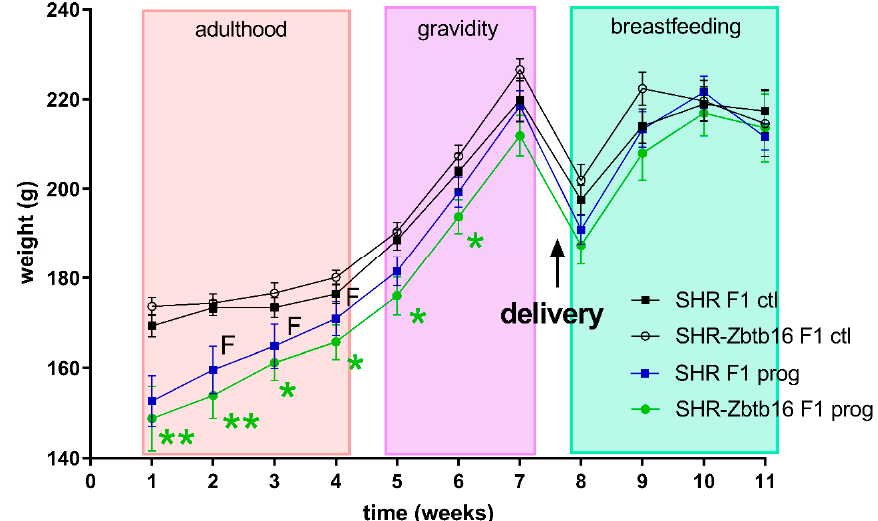
Figure 3. Body weight measurements of F1 SHR and SHR-Zbtb16 adult female rats during weeks prior to pregnancy (weeks 1–4), in pregnancy (weeks 5–7) and during lactation (weeks 8–11). Delivery occurred between weeks 7 and 8. SHR F1 controls—black boxes, F1-programmed SHR—blue boxes, SHR-Zbtb16 F1 controls—white circles, F1-programmed SHR-Zbtb16—green circles. Data are expressed as mean ± SEM. The strain comparison using the post-hoc Fisher’s least significant di ff erence test of the two-way ANOVA for STRAIN and PROGRAM as major factors are indicated as follows: * p < 0.05, ** p < 0.01. E ff ect of programming in SHR and SHR-Zbtb16 strains is represented by blue and green asterisks (*), respectively. F represents strain di ff erences between F1-programmed SHR and SHR-Zbtb16 dams, week 2 *, week 3 *, week 4 *, which were all higher in SHR F1-programmed dams.